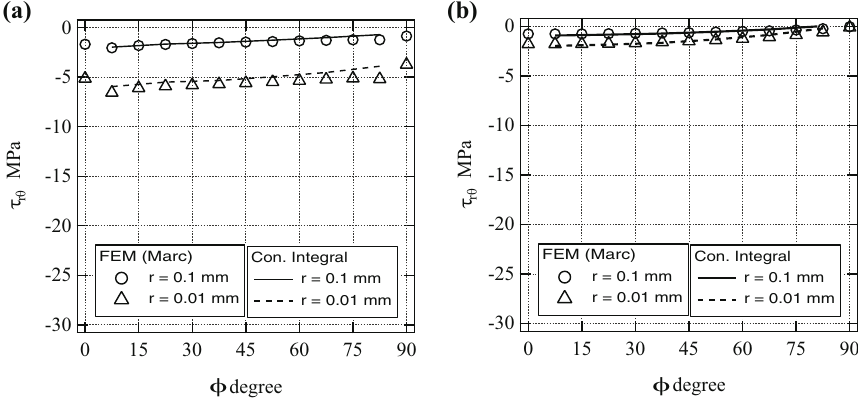
Figure 8: Distribution of shear stresses, τ rθ , at the interface, = θ 90° , with fi xed r at 0.01 and 0.1 mm: ( a ) Vertex - 1 and ( b ) Vertex -